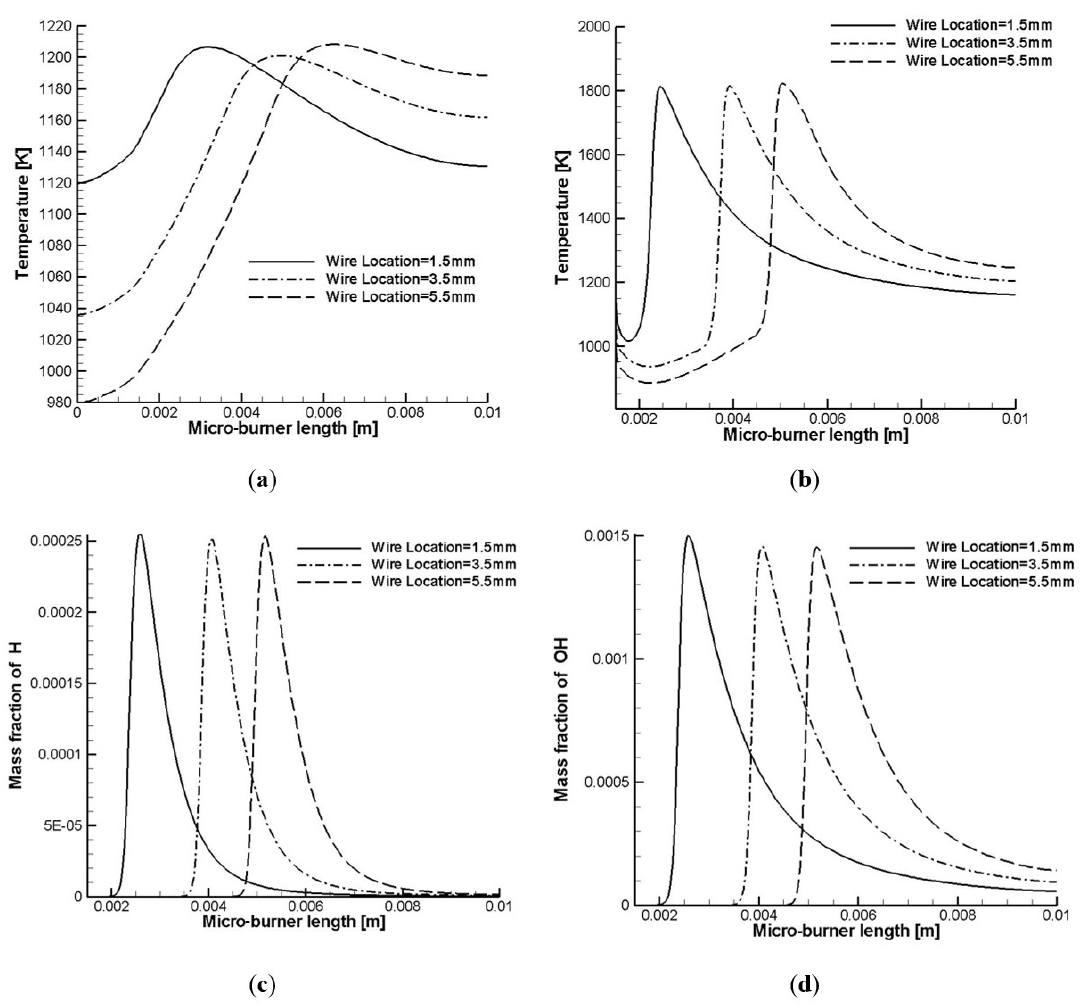
Figure 10. ( a ) Distribution of temperature on the outer surface of the micro-burner for different locations of the inserted wire; ( b ) distribution of temperature on the axial line defined at r = 0.3 mm for different locations of the inserted wire; ( c ) distribution of H mass fraction on the inner wall for different locations of the inserted wire; ( d ) distribution of OH mass fraction on the inner wall for different locations of the inserted